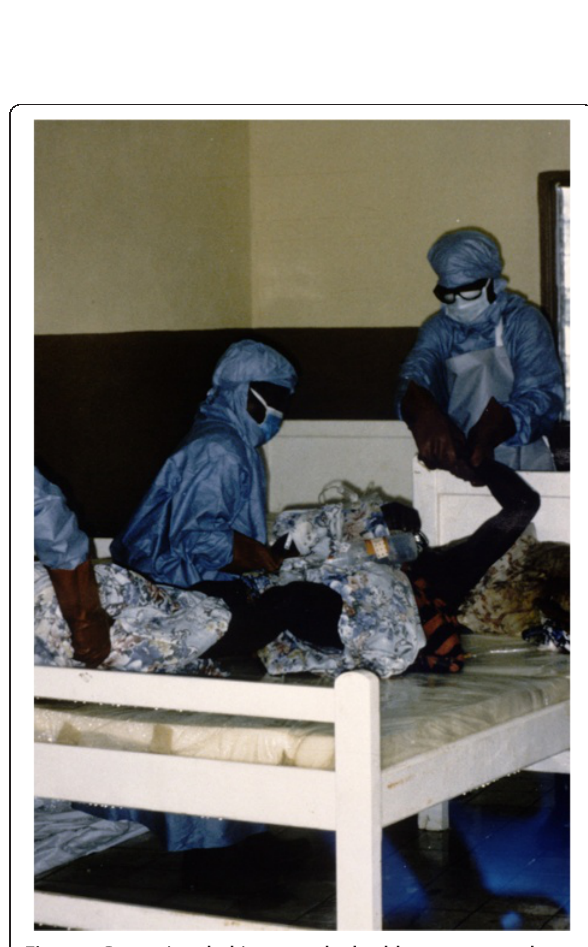
Figure 7 Protective clothing worn by healthcare personnel during the care and handling of a patient (photo by Jean-Paul Gonzalez, ©IRD).